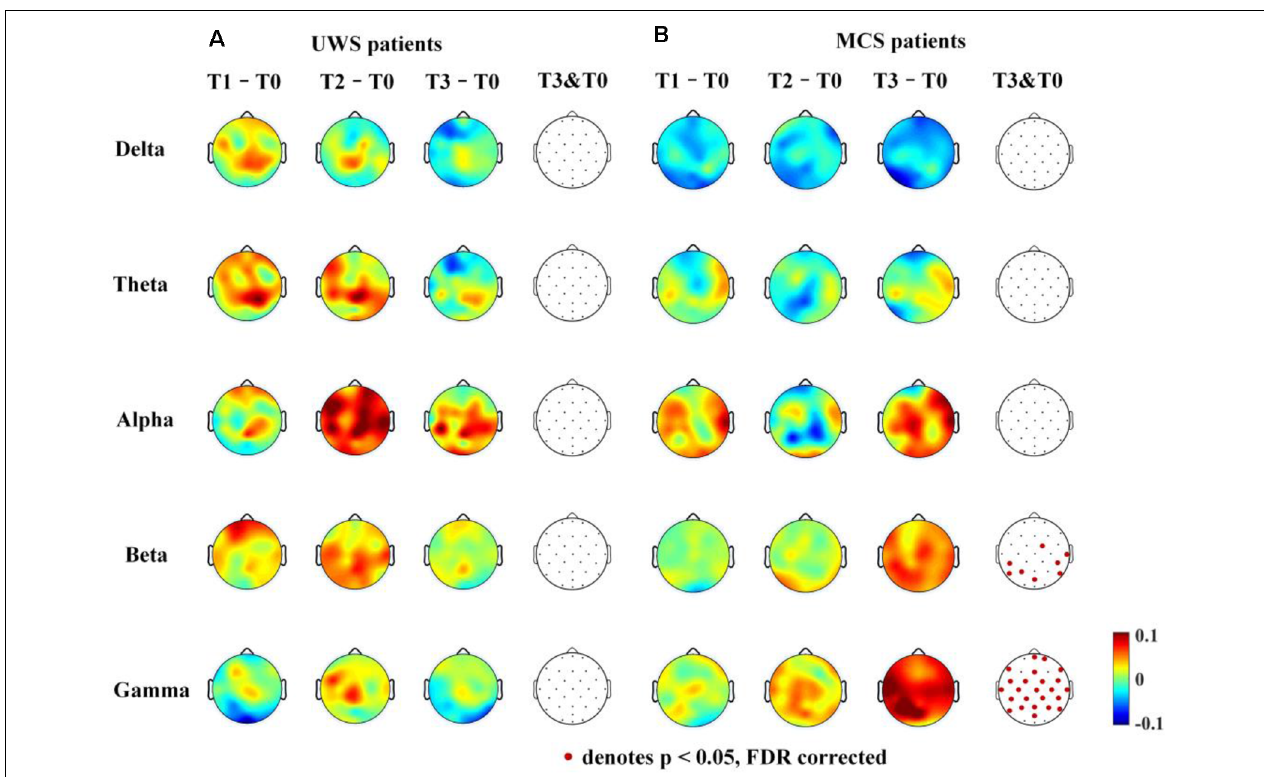
FIGURE 5 | Average nodal (cid:52) dwPLI (debiased weighted phase lag index) topographs (T1 – T0, T2 – T0 and T3 – T0) in UWS and MCS patients in terms of delta (1–4 Hz), theta (4–8 Hz), alpha (8–13 Hz), beta (13–30 Hz), and gamma (30–45 Hz) bands. The electrodes with significantly increased dwPLI (T0 → T3) are denoted by colored solid circles ( A , UWS patients; B , MCS